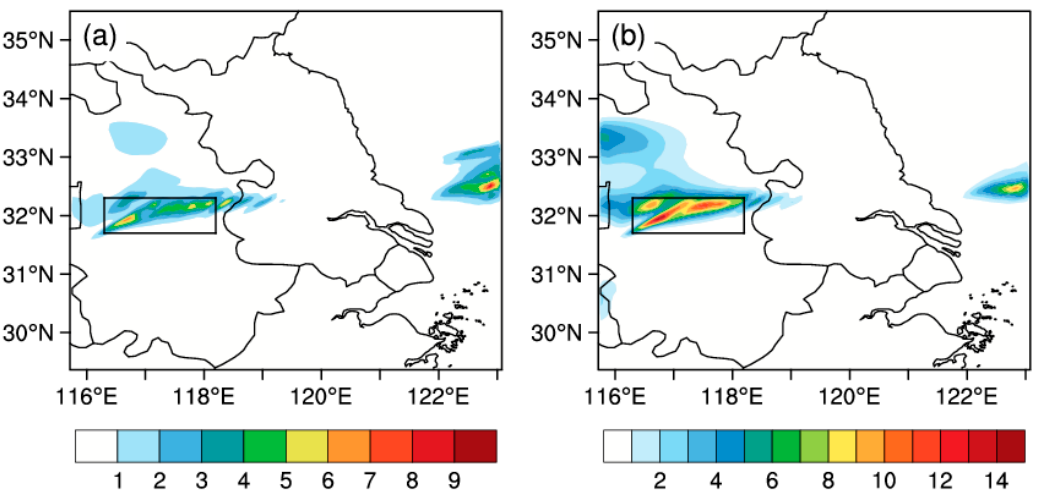
Figure 2. 12 July 2014, 0000 UTC to 0300 UTC results. ( a ) Spread of 3-h accumulated precipitation (unit: mm) and ( b ) 3-h accumulated precipitation (unit: mm). The black box indicates the response region.